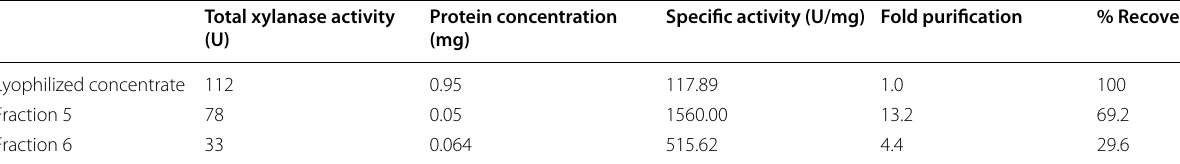
Table 2 Single-step purification of xylanase by Sephadex G-25 gel filtration chromatography